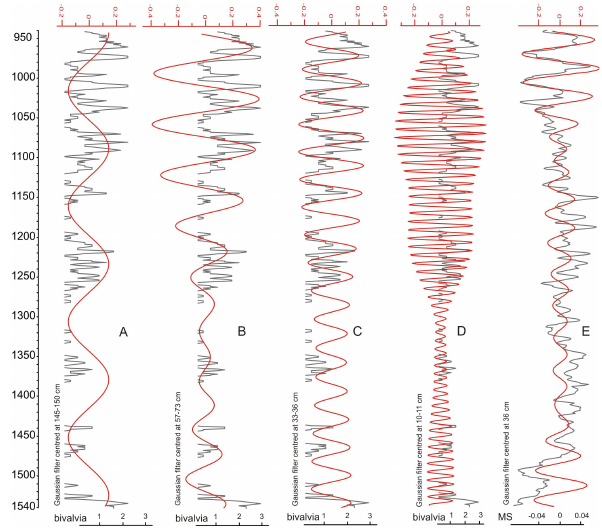
Fig. 5. Gaussian filters have been applied to the bivalve data accord- ing to the dominant periods revealed by the periodograms in Figs. 3 and 4. These filters are centered at 10–11, 33–36, 57–73 and 145– 150cm (A–D) . The two high-frequency filters explain most of the observed data. E shows magnetic susceptibility data from Kern et al. (2012a). The Gaussian filter centered at 36 cm represents the hy- pothetical 500yr cycle and is anticyclic compared with the bivalve record (C)